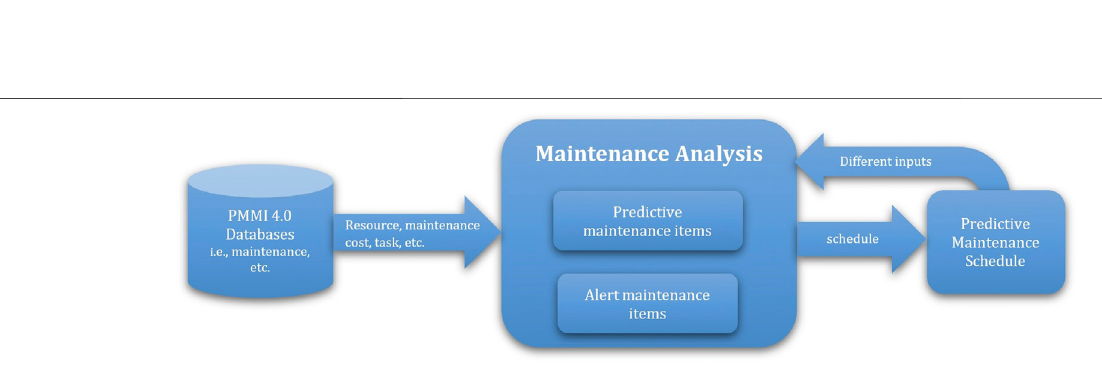
FIGURE 5 | PMMI 4.0 maintenance analysis for decision-supported maintenance.